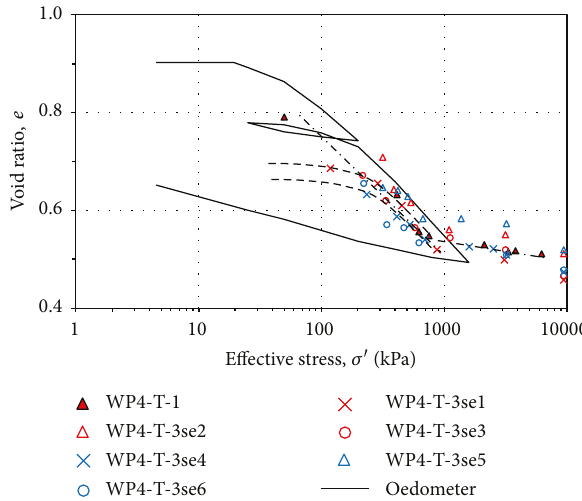
Figure 9: Results in terms of σ ′ - e compared with the conventional oedometer test results for the WP4-T-1 and WP4-T-3se1, WP4-T- 3se2, WP4-T-3se3, WP4-T-3se4, WP4-T-3se5, and WP4-T-3se6